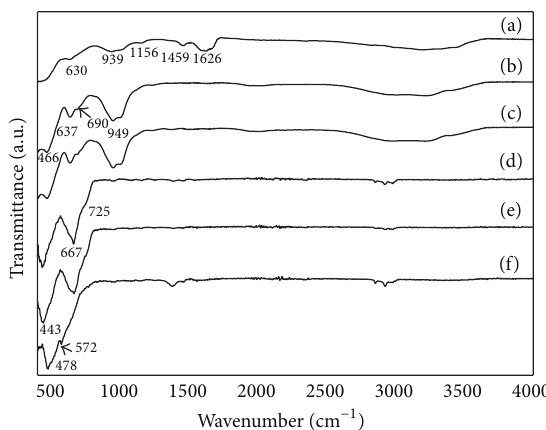
Figure 5: FT-IR spectra of GaO(OH) crystals precipitated from GaCl 3 solution with (a) decomposition of urea, (b) NH 4 OH, and (c) NaOH; FT-IR spectra of Ga 2 O 3 crystals after thermal conversion of GaO(OH) crystals hydrolysed with (d) urea, (e) NH 4 OH, and (f)